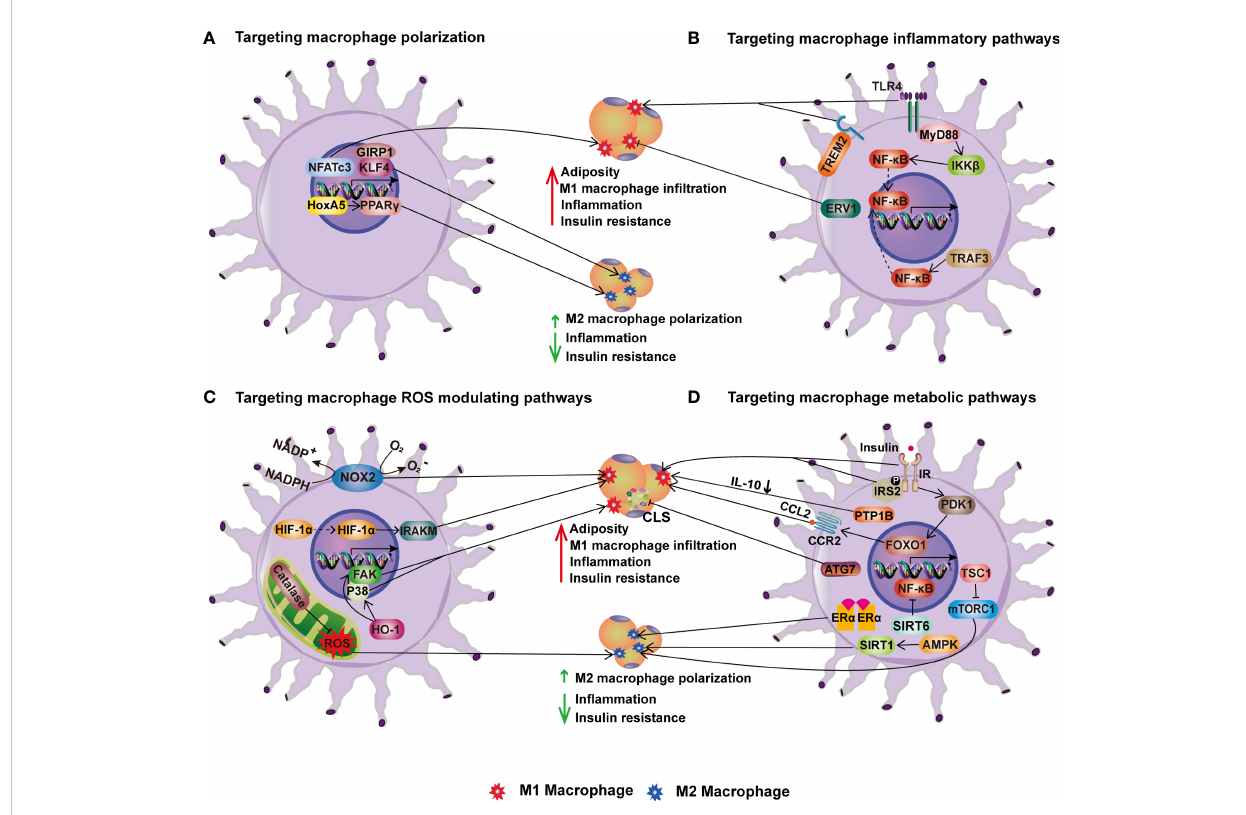
FIGURE 3 Targeting macrophages for improving metabolic health. (A) Targeting macrophage polarization. In HFD-induced obesity, transcription factors NFATc3, KLF4 and its coactivator GIRP1 enhance M1 macrophage polarization and in fi ltration into adipose tissue, in fl ammation, and insulin resistance. HoxA5 and PPAR, on the other hand, increase M2 macrophage polarization and thereby ameliorate obesity-induced in fl ammation and insulin resistance. (B) Targeting macrophage in fl ammatory pathways. TLR4-MyD88-IKK signaling and TRAF3 activation enhance adipose tissue M1 macrophage in fi ltration, in fl ammation, and IR in obesity via NF-B. On contrary, overexpression of ERV1 in macrophages reduces adiposity, hepatic and adipose in fl ammation, and hyperglycemia caused by HFD. (C) Targeting macrophage ROS modulating pathways. NOX2, HIF-1 a , and HO-1 in macrophages increase obesity- induced adiposity, in fl ammation, and insulin resistance, whereas catalase inhibits in fl ammation via increasing M2 macrophage polarization. (D) Targeting macrophage metabolic pathways. The stimulation of macrophage insulin pathways such as IR-IRS2 and PDK1-FoxO1 signaling promotes HFD-induced obesity and insulin resistance. PTP1B, an insulin signaling negative regulator, induces IR by lowering IL-10. In contrast, mTORC1 activation improves M2 macrophage polarization and protects mice from HFD-induced obesity, in fl ammation, and insulin resistance. In addition, the ATG7-mediated